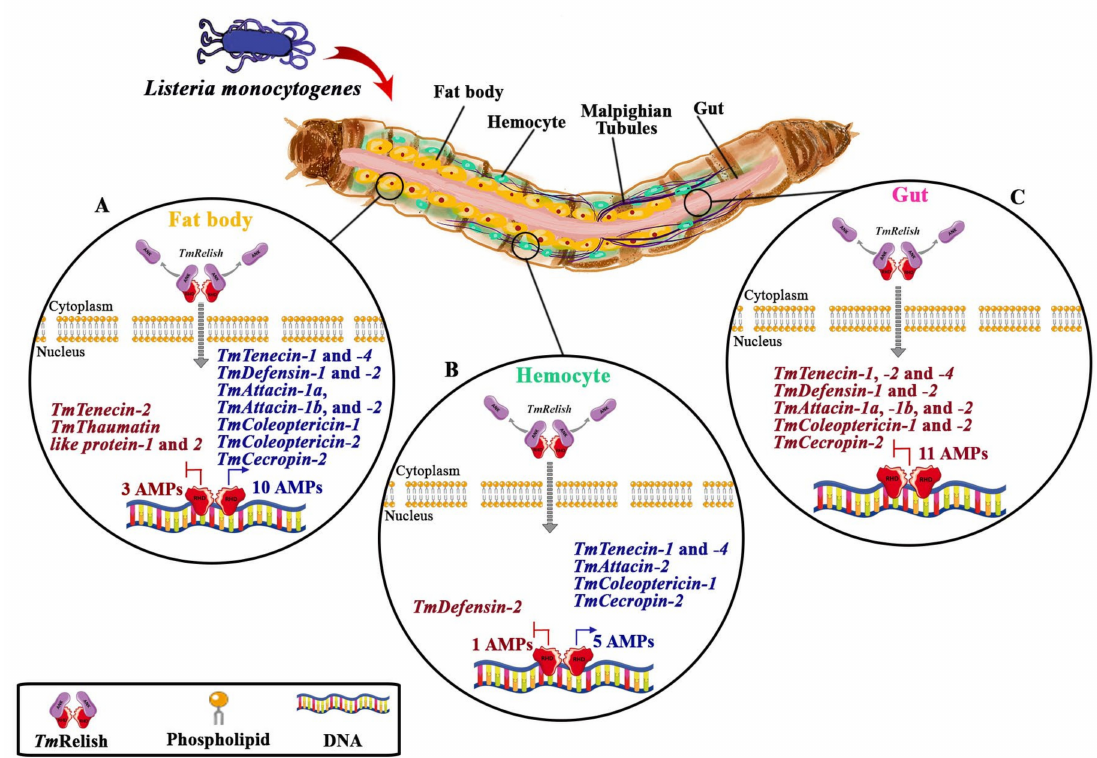
Figure 5. Schematic depiction of TmRelish -mediated activation of the immune-deficiency (Imd) pathway in the larval fat body ( A ), hemocytes ( B ), and gut ( C ) by L. monocytogenes . Upon intracellular infection, the N-terminus domain of TmRelish , the Rel homology domain (RHD), translocates from the cytoplasm to the nucleus to induce the expression of antimicrobial peptides (AMPs) in the larval fat body and hemocytes of T. molitor . Tm Relish negatively regulates the induction of several AMPs in the fat body, hemocytes, and gut of T. molitor larvae in response to L. monocytogenes